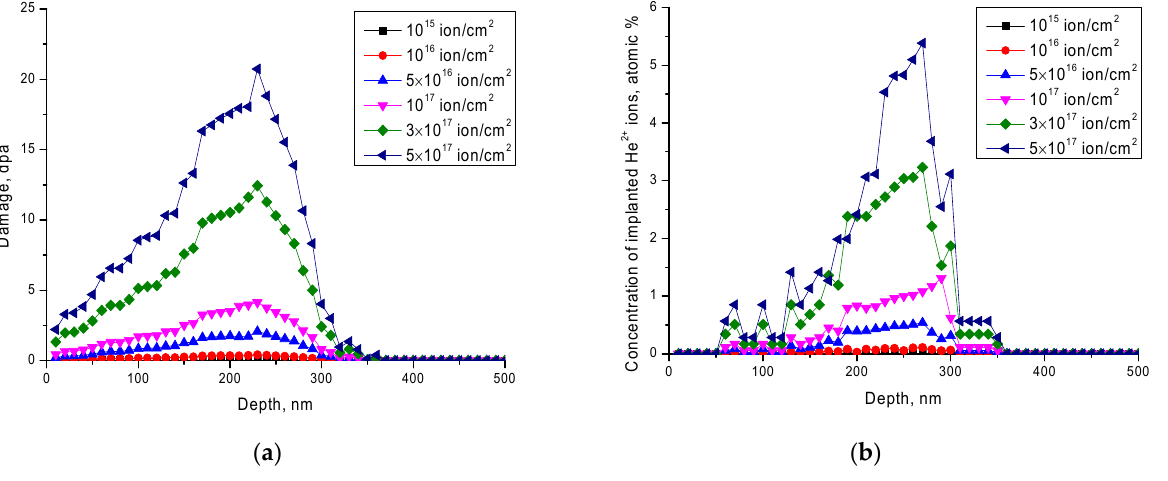
Figure 1. Results of radiation damage and ion implantation simulation: ( a ) distribution of the dpa value along the ion trajectory in the material at different radiation doses; ( b ) dependence of the change